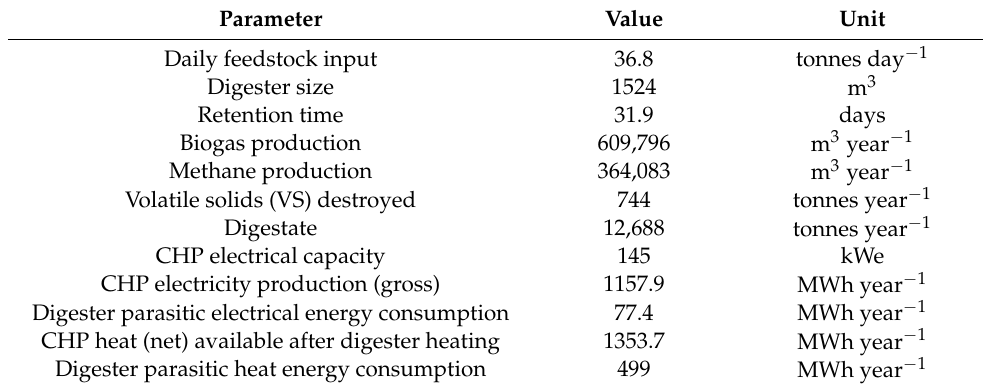
Table 4. Resultant ADAT model data (to be further utilised for the economic